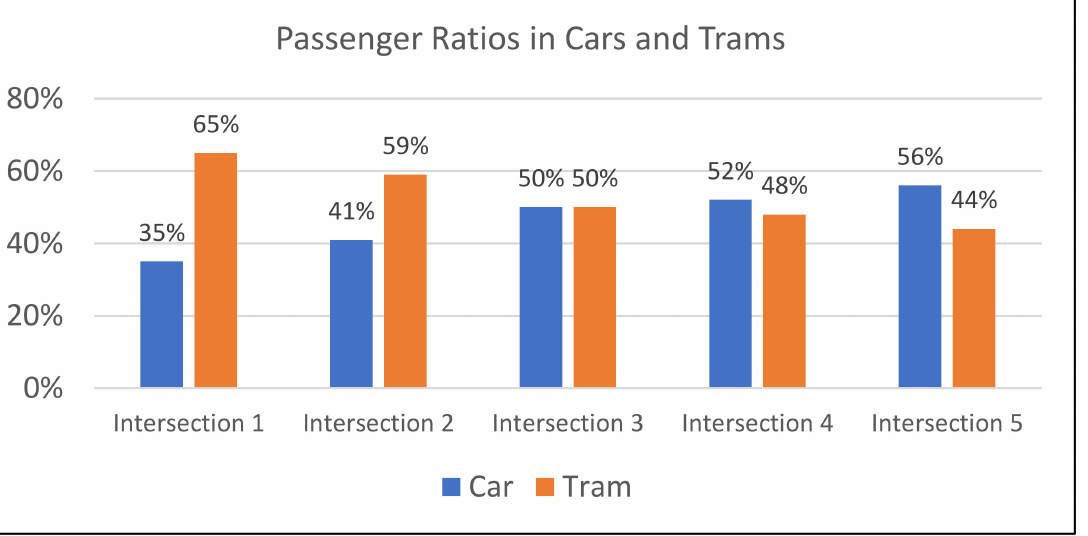
Figure 4. Passenger ratios in cars and trams on five most saturated